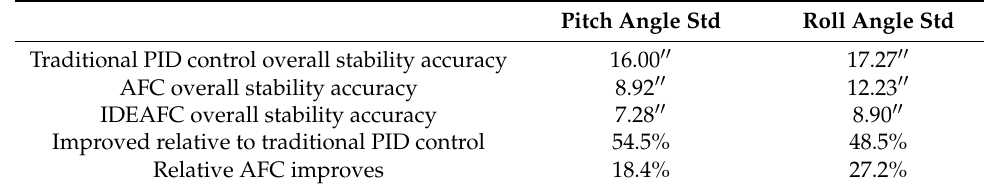
Figure 15. ( a ) Pitch angle data comparison; ( b ) roll angle data comparison. The comparison graphs show the control effects of the three control algorithms in the longitudinal rocking experiment, as shown in Table 4. Table 4. Comparison of control effect under pitching conditions.